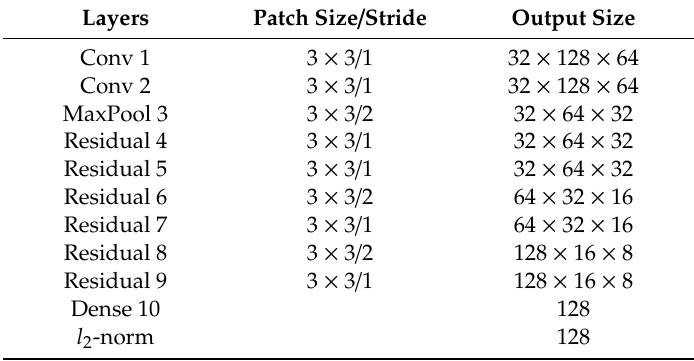
Table 1. The architecture of the wide residual network [63] trained for vehicle